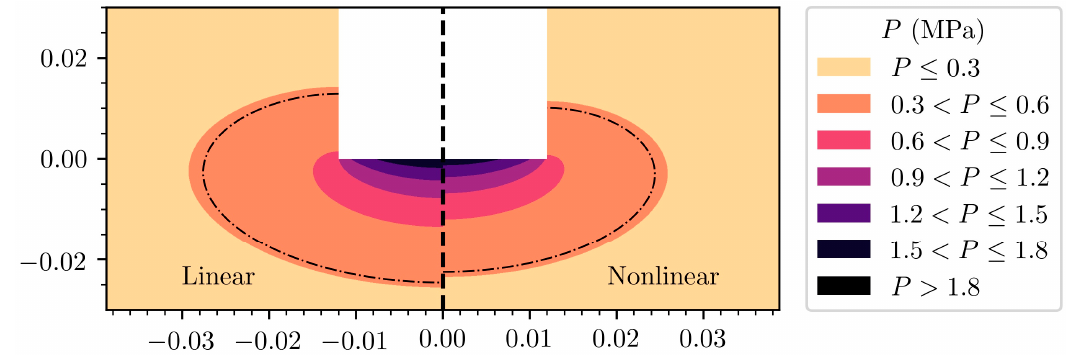
Figure 2. The di ff erence in predicted acoustic pressures between linear and nonlinear models. The nonlinear model includes the attenuating e ff ect of cavitating bubbles below the sonotrode. The dash-dotted line denotes the Blake threshold for hydrogen bubbles in aluminium, with R 0 = 3 µm.